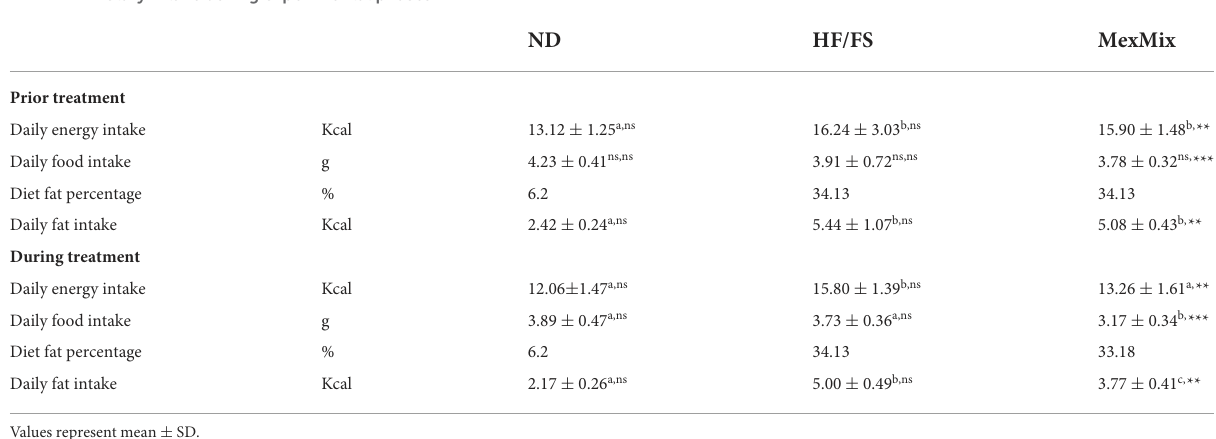
observed. Most cells were two times as large as others, suggesting a process of hyperplasia. Areas with an increased extracellular matrix were observed, secondary to a chronic inflammatory infiltrate of mononuclear predominance ( ∗ ) and congestive blood vessels. The MexMix diet prevented and reverted the effect